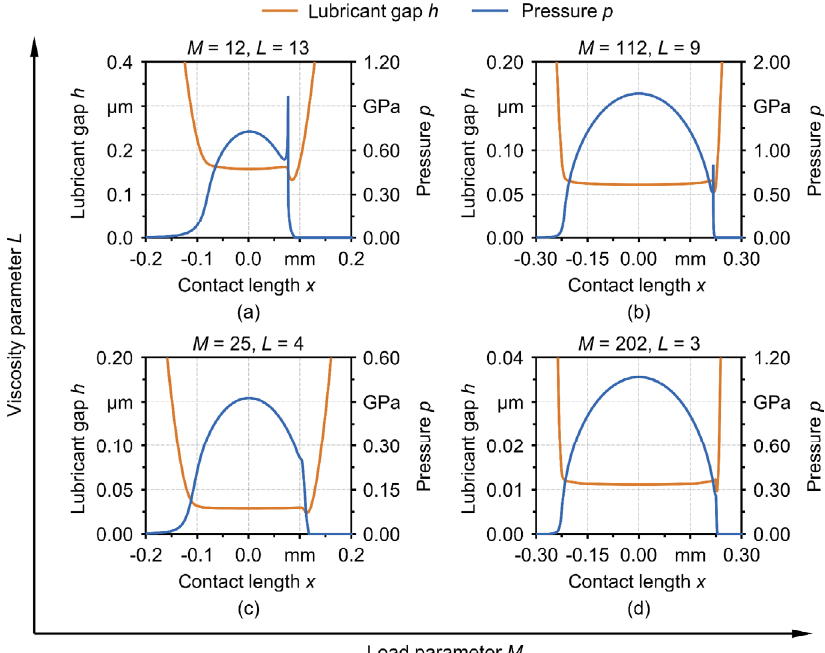
Fig. 5 Representative distributions of the lubricant film and the hydrodynamic pressure along the contact length for the infinite 2D line contact with four exemplary cases including (a) lower M and higher L , (b) higher M and higher L , (c) lower M and lower L , and (d) higher M and lower L